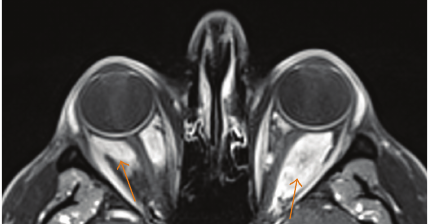
Figure 7: A 35-year-old male with contrast-enhanced, fat- suppressed axial T1 image showing homogeneous enhancement of soft tissue lesions (arrows) in the retrobulbar space which encases the optic nerves bilaterally. The globes are unremarkable. The optic nerves are normal in signal and without